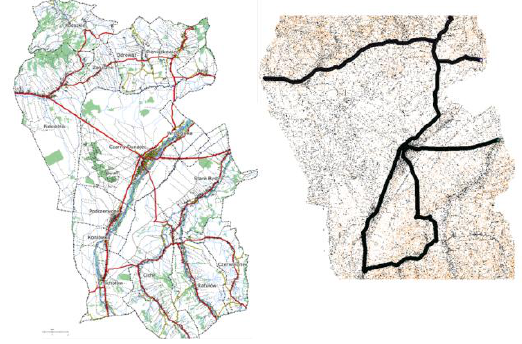
Figure 12. A map of the district of Czarny Dunajec (left) and routes recorded with immersive camera (right).